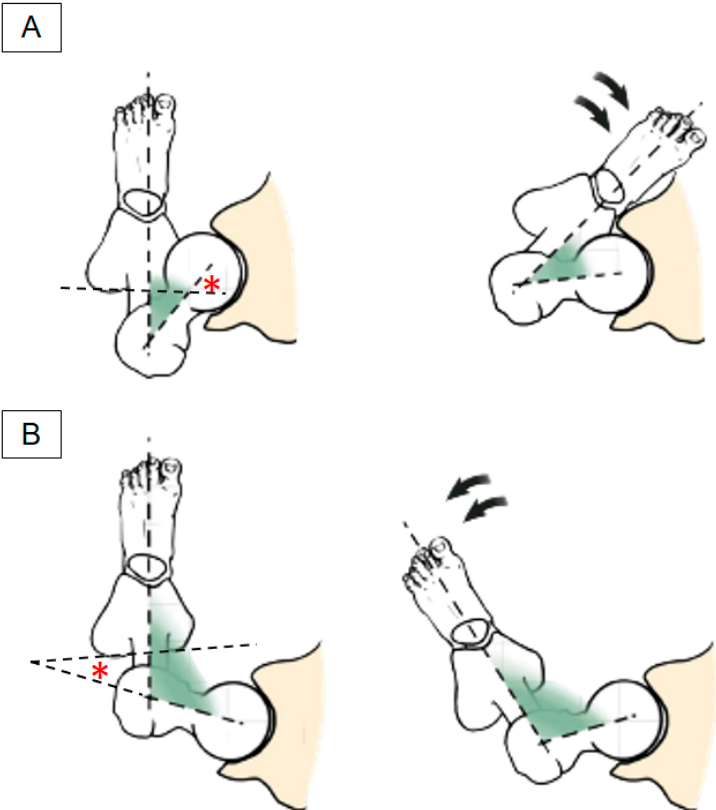
Figure 3. ( A ) Illustration of femoral anteversion (left) and compensatory toe-in posture (right); ( B ) illustration of femoral retroversion (left) and compensatory toe-out posture (right). * denotes the femoral anteversion angle.